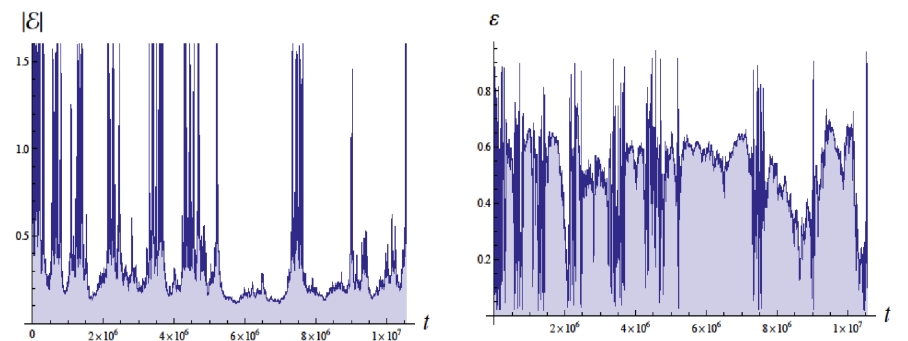
Figure 4. Plots of the energy E (left side) and eccentricity (cid:101) (right side) as a function of time in units of t 0 for Z = 3, for 1.5 × 10 6 revolutions. The energy for the ground state in quantum mechanics would be 0.5 with the scale used (Bohr units). Figure from [4] with